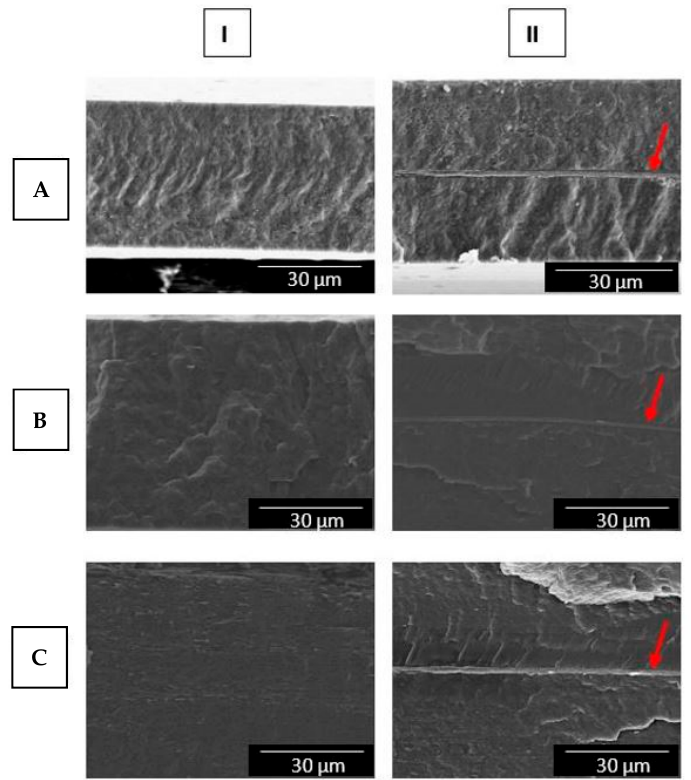
Figure 2. Scanning electron microscopy (SEM) micrographs of the cross-sections of the multilayer films of: ( A ) poly(3-hydroxybutyrate- co -3-hydroxyvalerate) containing 8 mol.% 3-hydroxyvalerate (PHBV8), ( B ) poly(3-hydroxybutyrate- co -3-hydroxyvalerate) with 2 mol.% 3-hydroxyvalerate (PHBV2), and ( C ) poly(3-hydroxybutyrate) with poly(butylene adipate- co -terephthalate) blend (PHB Blend), without ( I ) and with cellulose nanocrystals (CNCs) ( II ) coating. Images were taken at 1500× with scale markers of 30 µm. Red arrows indicate the CNC layer.